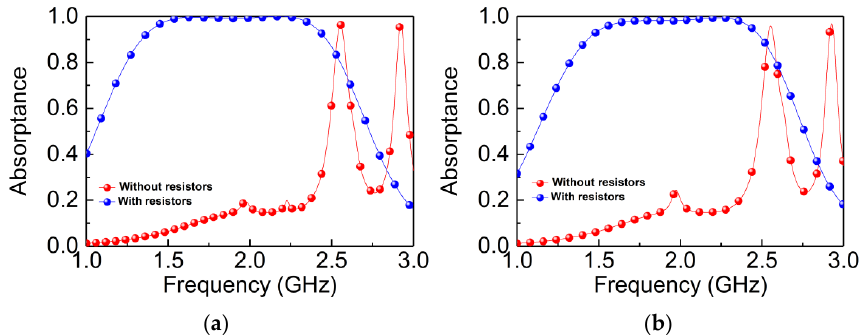
Figure 5. Simulated absorptance with and without resistors: ( a ) TE wave; ( b ) TM wave.